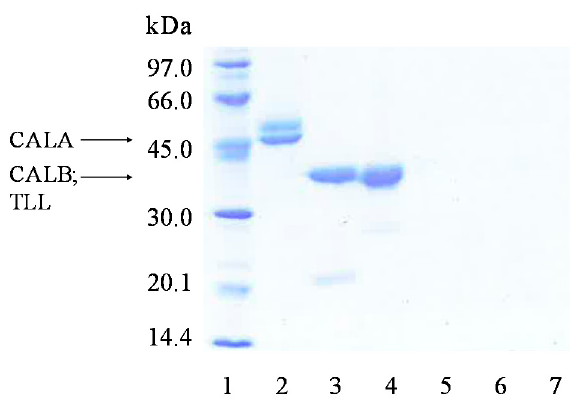
Figure 5. SDS-PAGE analysis of the irreversibly immobilized enzymes. Lane 1: Low weight molecular markers; Lane 2: octyl-CALA; Lane 3: octyl-CALB; Lane 4: octyl-TLL; Lane 5: octyl-VS-CALA; Lane 6: octyl-VS-CALB and Lane 7: octyl-VS-TLL. Other specifications are described in Methods.